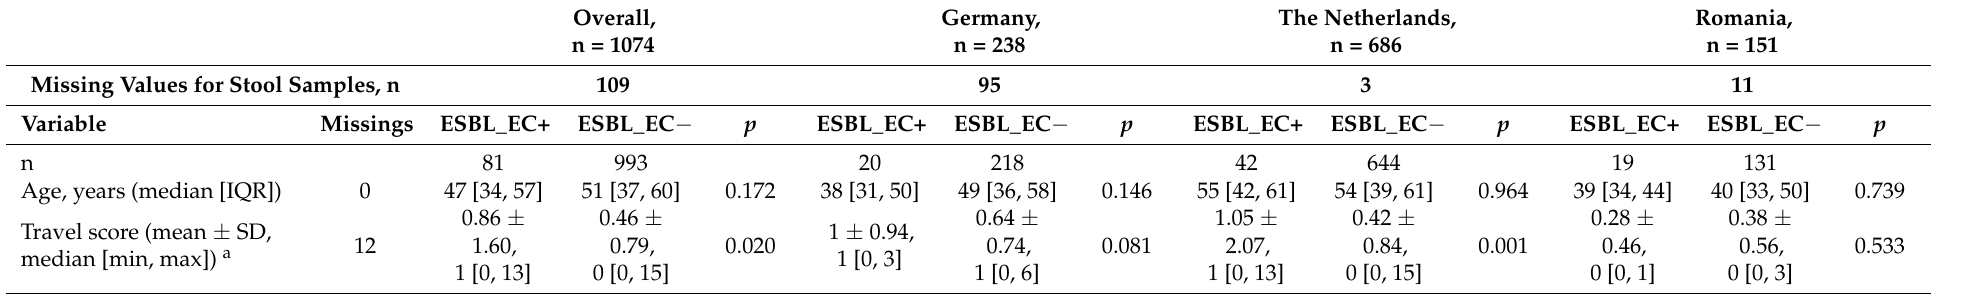
Table 2. Numerical descriptive characteristics of ESBL-producing E. coli carriers by